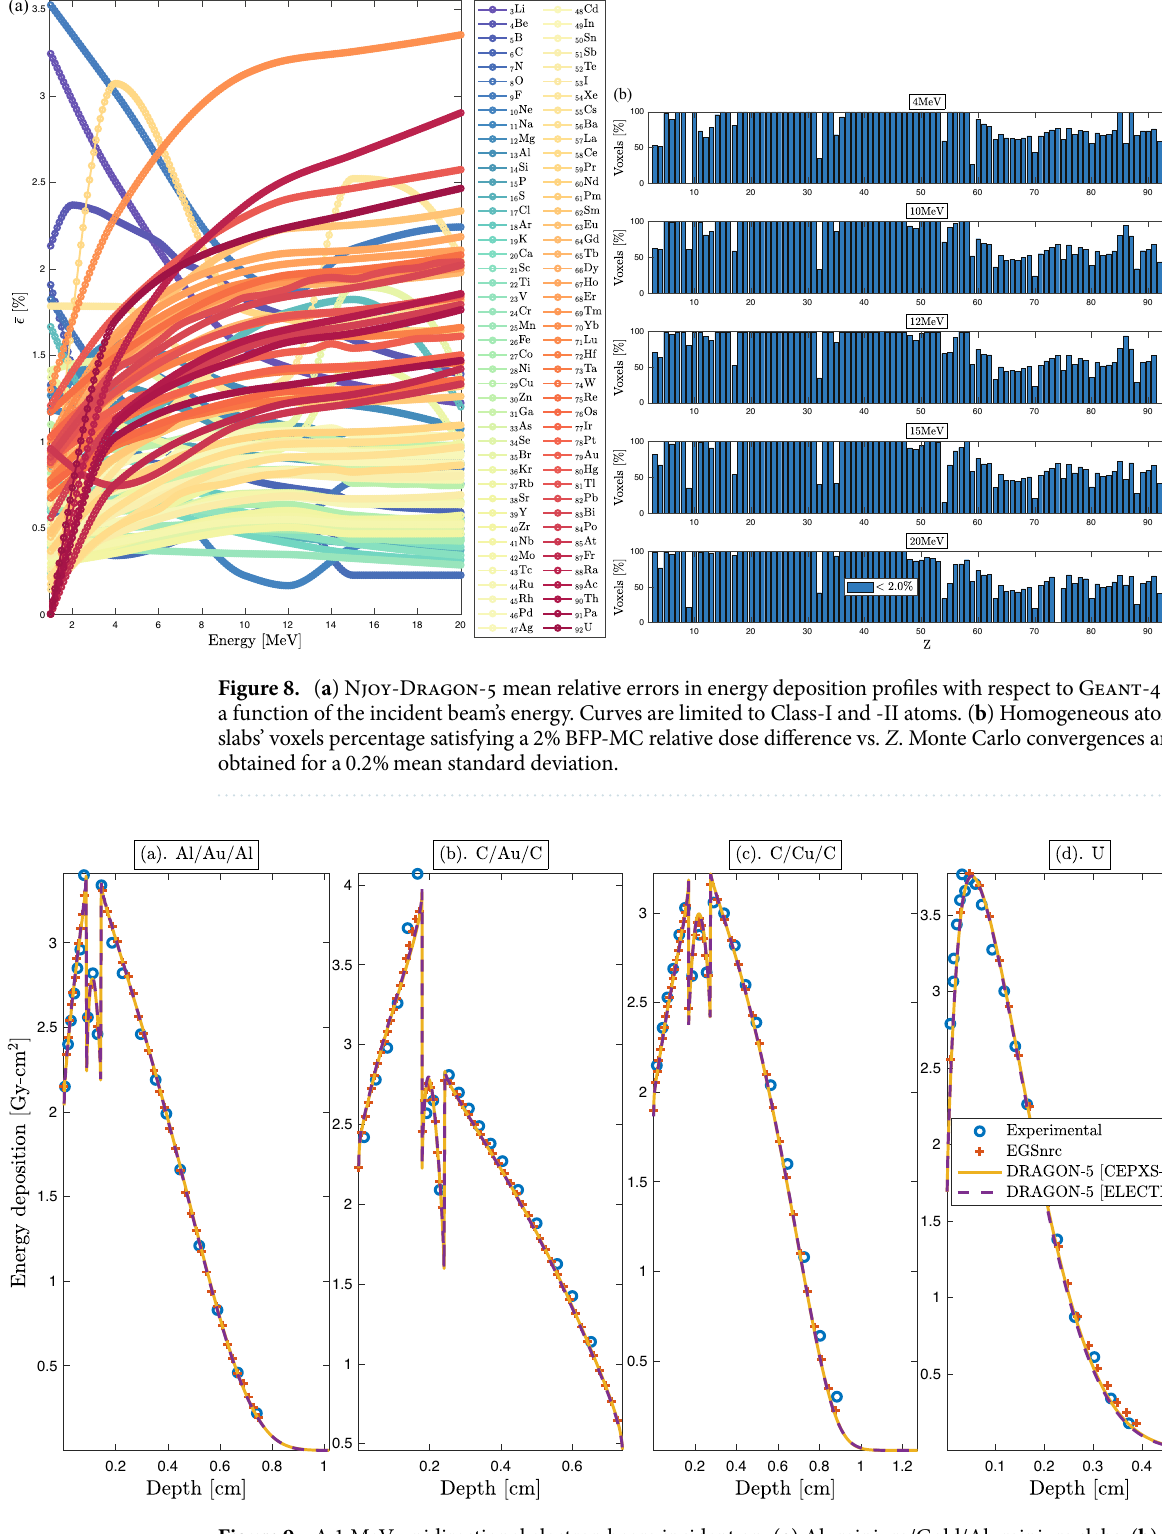
Figure 9. A 1 MeV unidirectional electron beam incident on: ( a ) Aluminium/Gold/Aluminium slabs; ( b ) Carbone /Gold/ Carbone slabs; ( c ) Carbone/Copper/Carbone; and ( d ) Uranium slab. Experimental energy depositions are from Lockwood’s calorimetric measurements 68 . Here, EGSnrc is the reference Monte Carlo code. Two deterministic calculations are shown. The first corresponds to Dragon-5 feeded with an FMAC-formatted library based on the CEPXS-BFP code, while the second to the NJOY [ELECTR]–Dragon-5 chain. Dimensions are fixed to the incident beam’s range within the irradiated